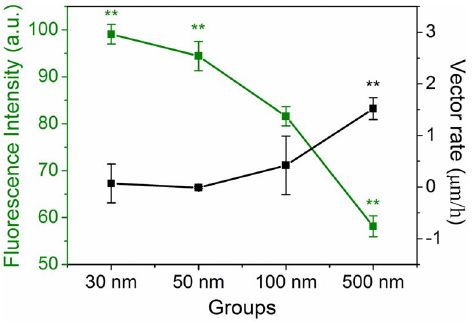
Figure 7. The relationship between effective NP loading and RAW 264.7 cell vector migration. Fluorescence intensity statistics for RAW264.7 cells treated with four varisized intracellular NPs (green line). Vector rate of RAW264.7 cells for different pre-treatment conditions (black line). * p , 0.05, **p , 0.01 compared with 100-nm NPs treated group (Error bar is